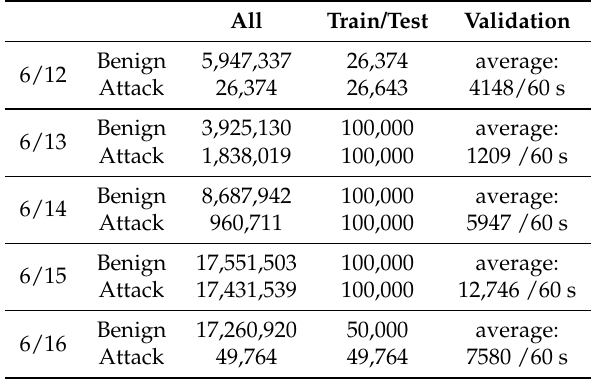
Table 5. Train/Test/Validate traffic proportion in the ISCX-IDS-2012 dataset. All